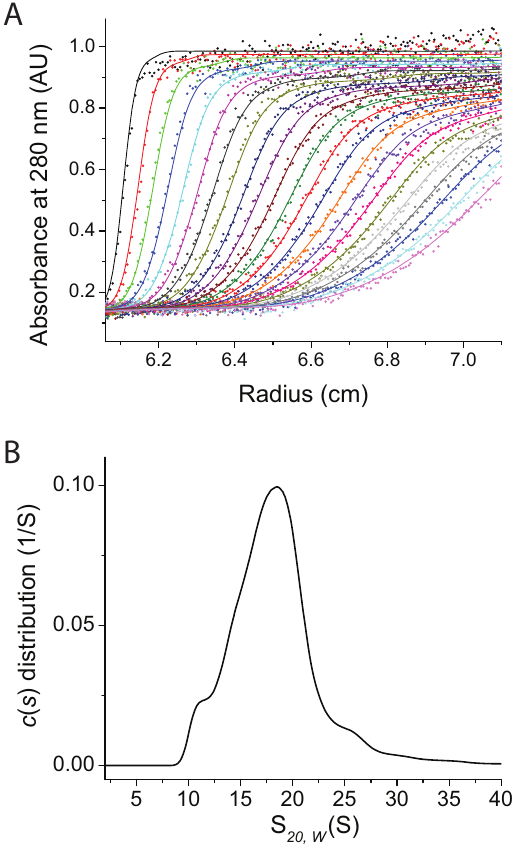
Figure 3. Size distribution of A b 42 CC protofibrils in solution monitored by analytical ultracentrifugation. (A) A subset of the raw sedimentation velocity centrifugation data of 300 m M A b 42 CC protofibrils at 20 u C recorded over a period of 20 h. (B) Sedimentation coefficient distribution of A b 42 CC protofibrils analyzed using a continuous c( s ) distribution model.